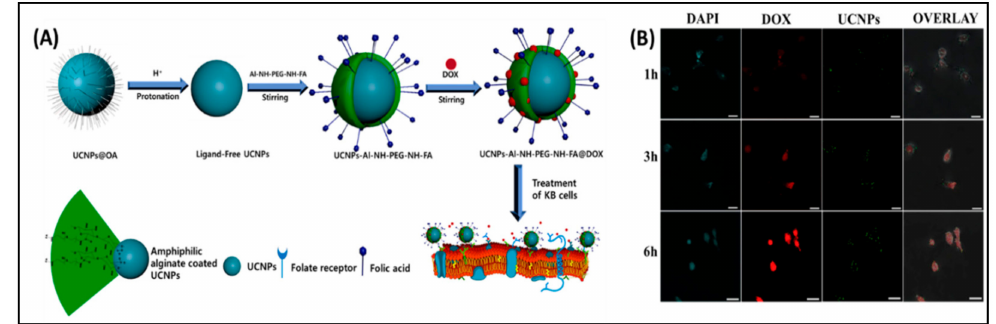
Figure 8. ( A ) Preparation of UCNP-Al-NH-PEG-NH-FA nanomicelles ( B ) Bioimaging results of KB cells treated with DOX-loaded UCNP-Al-NH-PEG-NH-FA for different time (1 h, 3 h, and 6 h) at 37 ◦ C. Reprinted with permission from [17]. Copyright © 2018,